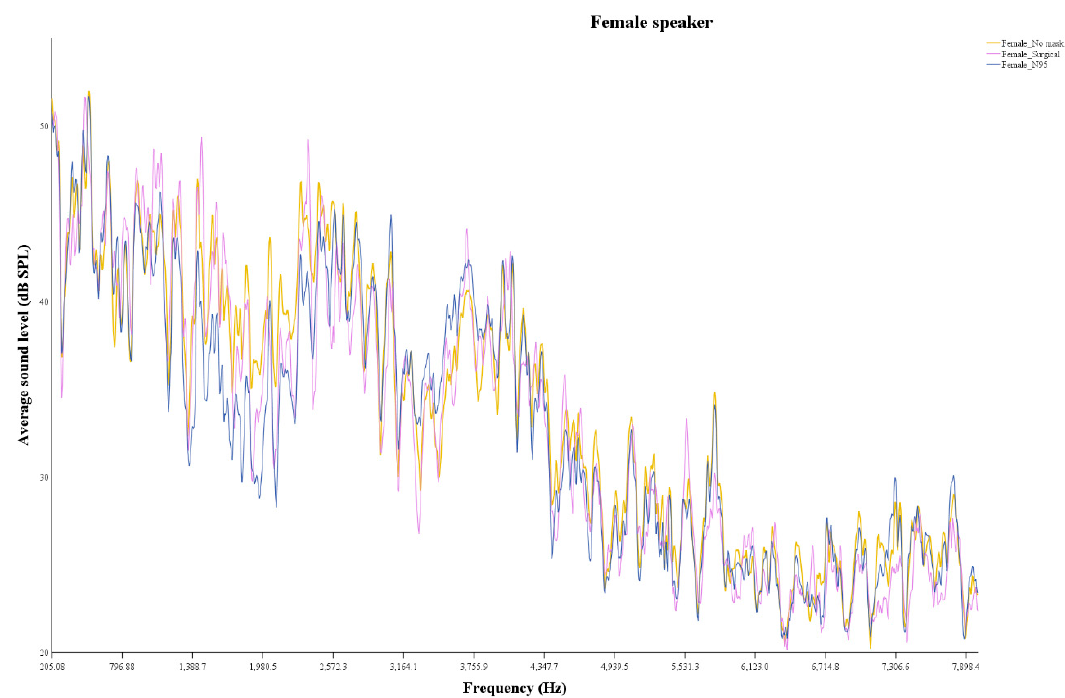
Figure 2. Average sound pressure level for female speaker.